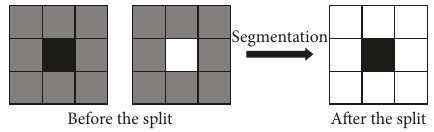
Figure 1: Schematic diagram of segmentation 2 ; (3) multiply the result of step di n x, y difference μ ( ( ) − ) (2) by 225 to complete the calculation of the left inequality; (4) calculate the 225-pixel values in the processing window and complete the calculation of the inequality on the right with the square sum of μ ; (5) compare steps (3) and (4) to complete the local adaptive threshold segmentation; (6) align the rows and columns, and complete the boundary processing. The overall design of implementing locally adaptive threshold segmentation in FPGA is shown in Figure 2.